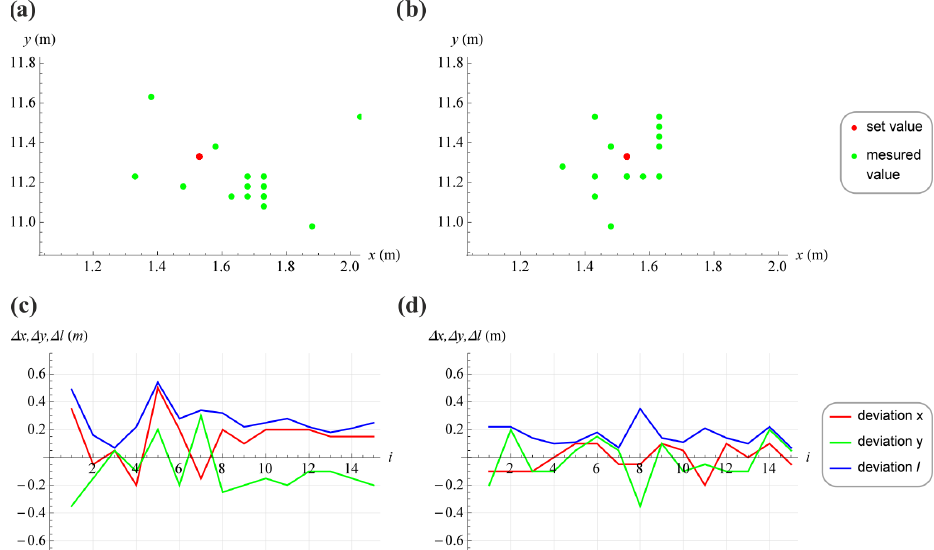
Figure 9. Accuracy measurement of point 2. ( a ) Green points represent measured positions when the robot stops. The red point is an aim point. In this experiment, the robot had a vision system turned off. ( b ) The robot had the vision system turned on. ( c ) Deviations from the aim point in x and y , where the vision system was off. ( d ) Deviations from the point where cameras the vision system was on.